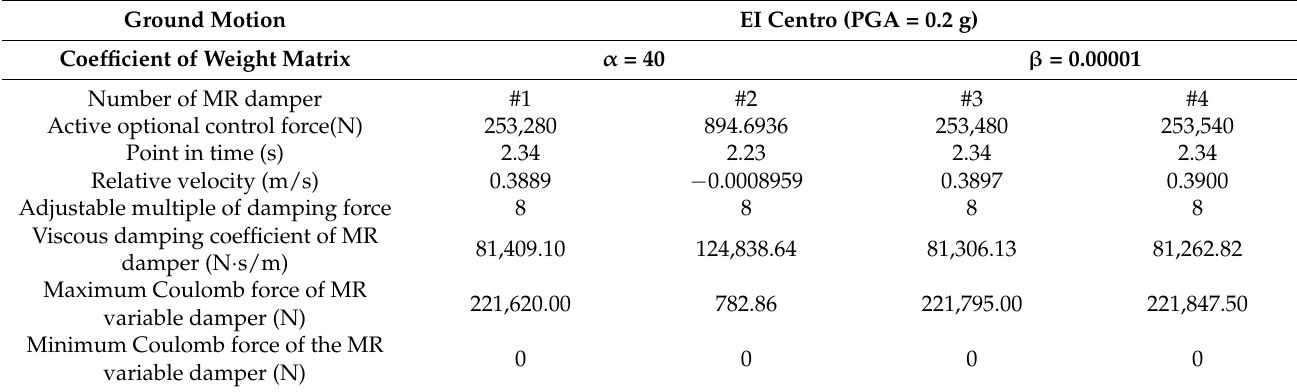
Table 2. Parameter design table of MR damper.